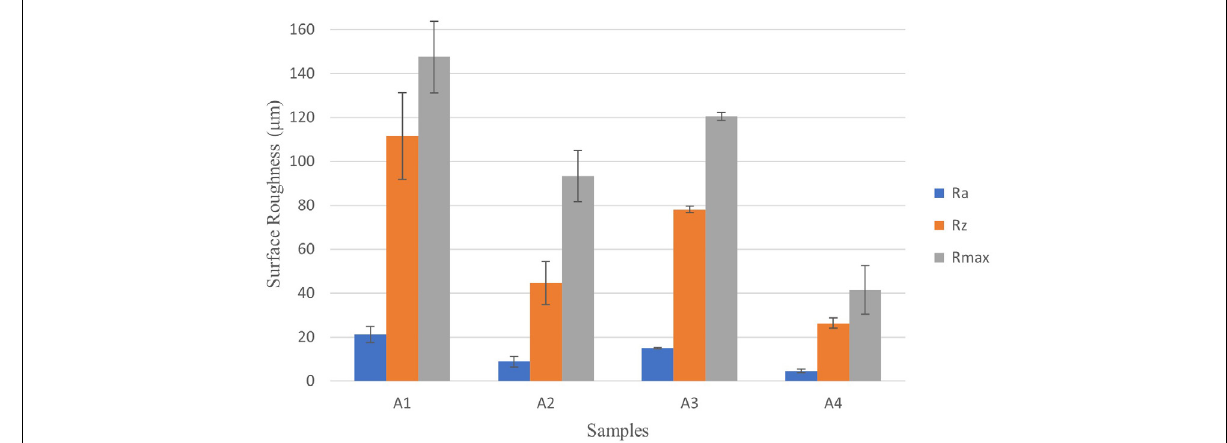
Figure 5: Effect of laser power on surface